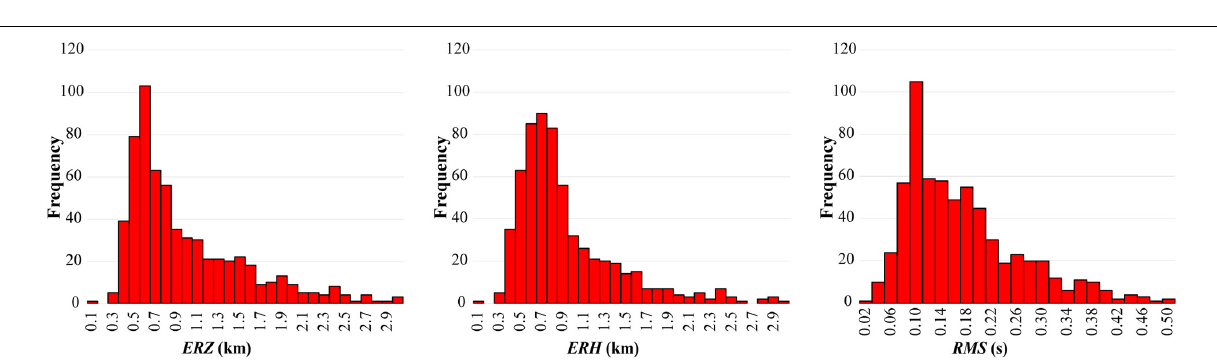
These histograms indicate the high quality of the